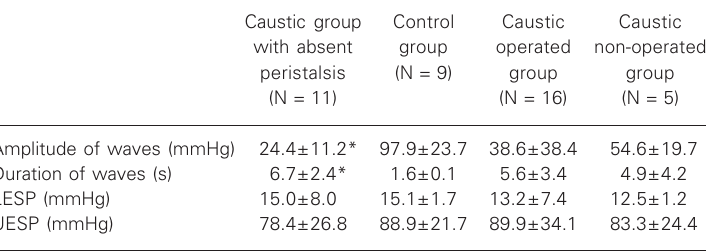
Figure 1. Manometry recording obtained at the level of the esophageal body after a 5-ml water swallow (W). Each record shows three deglutition com- plexes. Time elapsed between two dotted vertical lines = 4 s. Each horizontal line indicates a pressure sensor placed 3 cm apart for patient 1 and 5 cm apart for patient 15. A , Patient number 1: low amplitude con- tractions and esophageal aperi- stalsis, elevated basal pressure, low-amplitude waves, and exag- gerated transmission of aortic pulse. B , Patient number 15: segmental disorders in middle and distal segment.